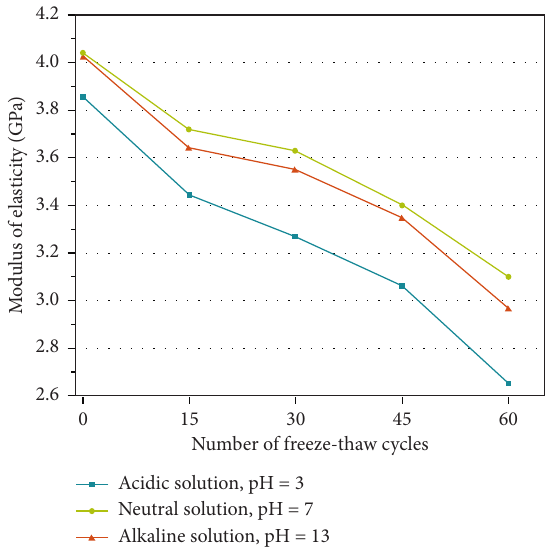
Figure 7: Relationship curves of elastic modulus and number of freeze-thaw cycles of sandstone samples under different chemical solution erosions.